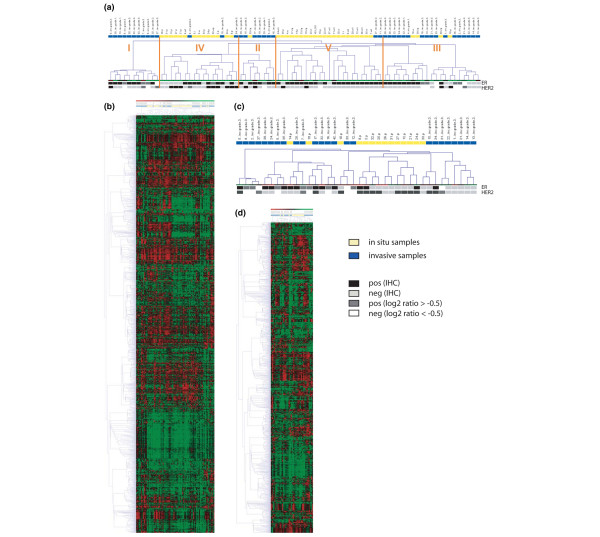
Unsupervised hierarchical clustering of in situ and invasive samples. (a) Dendrogram of all in situ (n = 40) and all invasive (n = 40) samples. (b) Scaled-down representation of the entire cluster shown in (a) (1,706 genes). (c) Dendogram of poorly differentiated ductal carcinoma in situ (n = 14) and grade 3 invasive (n = 24) samples. (d) Entire cluster of (c) (1,119 genes). Yellow indicates in situ samples, and blue indicates invasive samples. i, intermediately differentiated; IHC, immunohistochemistry; i/p, intermediately/poorly differentiated; LCIS, lobular carcinoma in situ; p, poorly differentiated; w, well differentiated; w/i, well/intermediately differentiated.